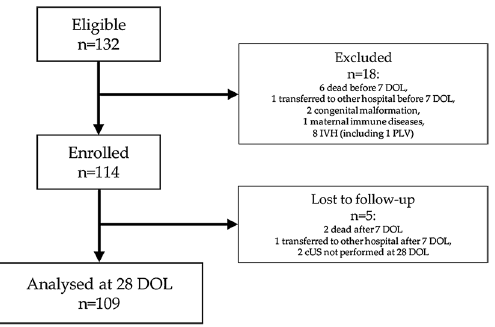
Figure 1. Flow-chart. DOL days of life, IVH intraventricular hemorrhage, PLV Periventricular Leukomalacia, cUS cranial